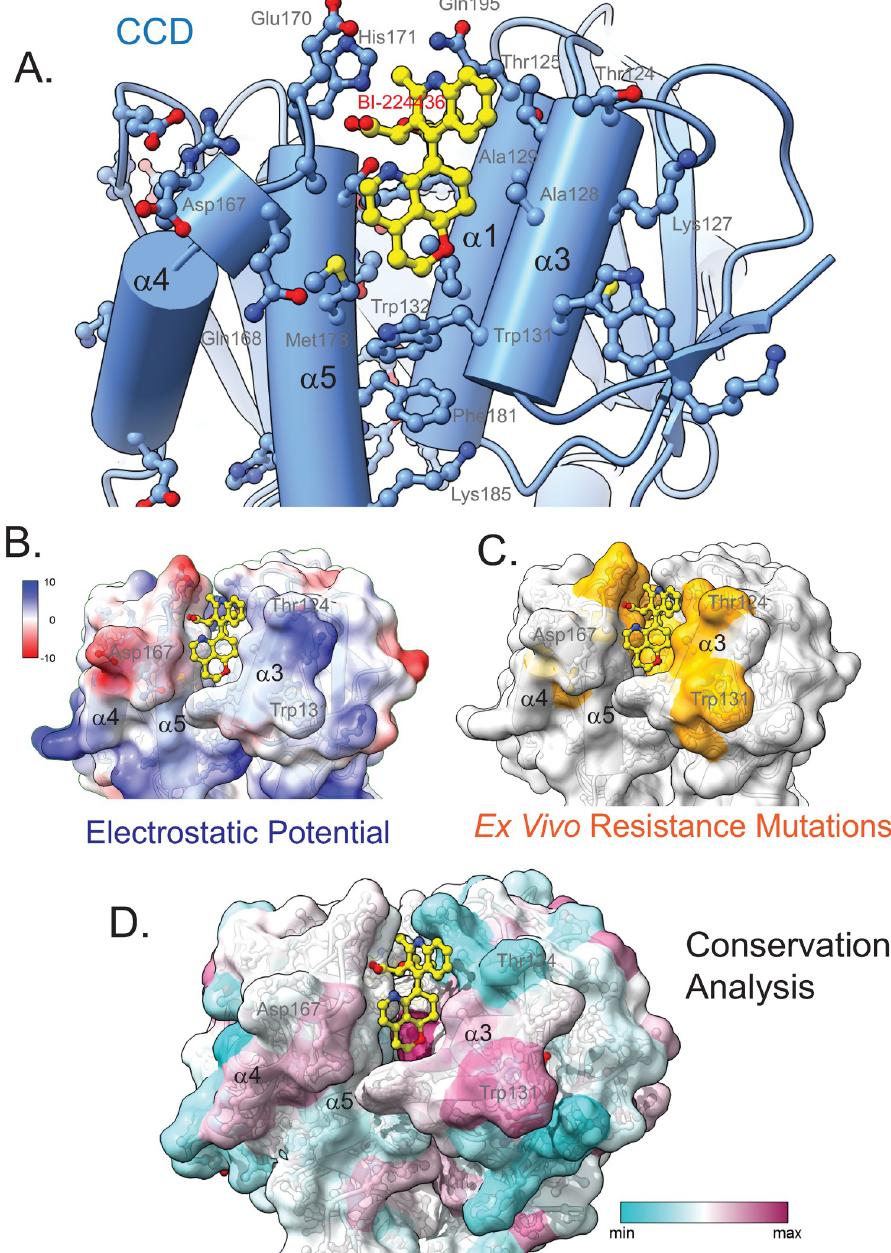
Fig 5. CCD interactions with BI-224436 within the minimal ternary complex. A. Shown is a view of the site I BI- 224436 binding site on the CCD, with the CTD omitted for clarity. Helices α 3 and α 1 from one monomer subunit and α 5 and α 4 from another monomer subunit are shown cradling the drug (yellow). B. Electrostatic surface of ALLINI- bound CCD, with the CTD omitted for clarity. Red denotes electropositive surfaces and blue denotes electronegative surfaces. C. Known ex vivo resistance mutation sites are shown in orange on the same ALLINI-bound CCD view. D. Conservation analysis, using the 2019 HIV IN collection of sequences at the Los Alamos database that includes all subtypes (4,326 sequences) of HIV-1 IN, as well as subtype M from HIV-1/SIVcpz (2,471 sequences). Alignments were prepared and used in the calculation of sequence conservation scores using the entropy-based method from AL2CO [63] program implemented in the UCSF ChimeraX [64]. All Figs were created using the program UCSF ChimeraX. Regions of high conservation are shown in red and regions of low conservation are shown in